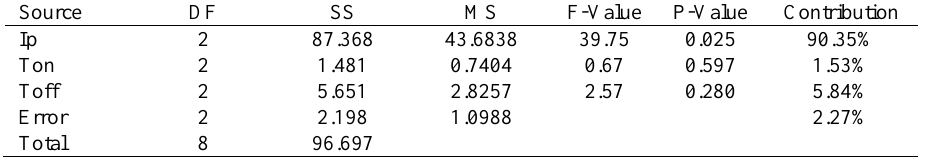
Table 5. ANOVA for S/N ratio of Gr electrode material removal rate.